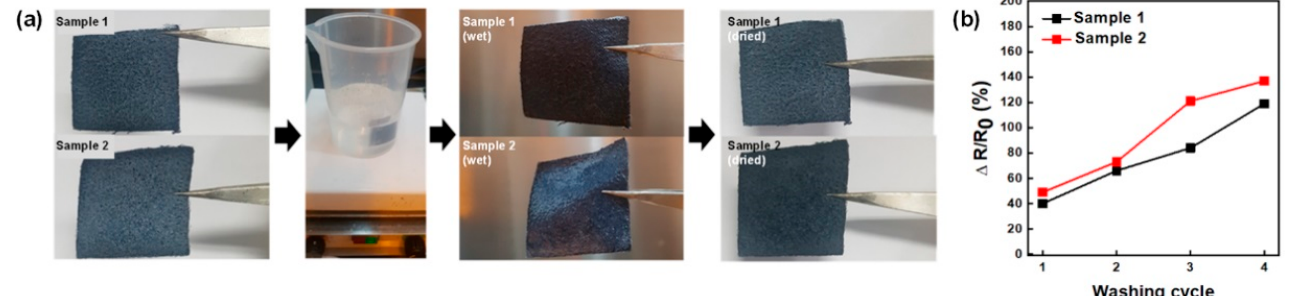
Figure 6. ( a ) Washing test and ( b ) sheet resistance ageing test of